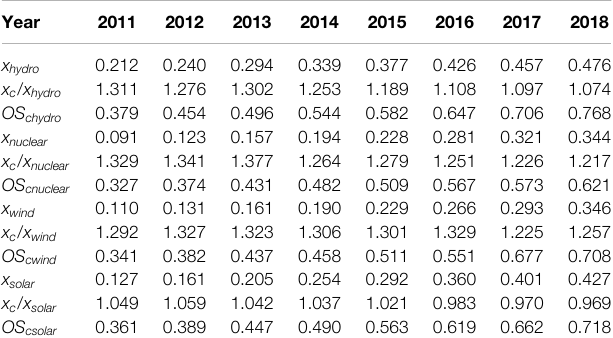
TABLE 5 | Orderliness-synergy degree and ratio of development speed for both the conventional energy industry and the sub-sectors of the nonconventional energy industry in 2011 – 2018.